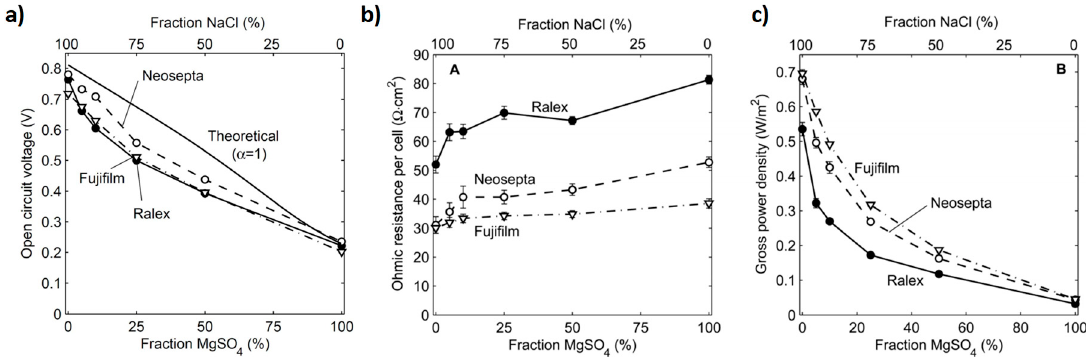
Figure 4. The impact of multivalent ions for RED systems tested using di ff erent commercial membranes (Ralex, Neosepta, or Fujifilm membranes). ( a ) Ppen-circuit voltage (OCV), ( b ) ohmic resistance, and ( c ) gross power density as a function of the molar fraction of MgSO 4 of the total dissolved salts in the feed solutions. Experimental results are reported as an average of a stationary data series measured over 1 h. Reproduced with permission from [8]. Copyright 2015 Royal Society of